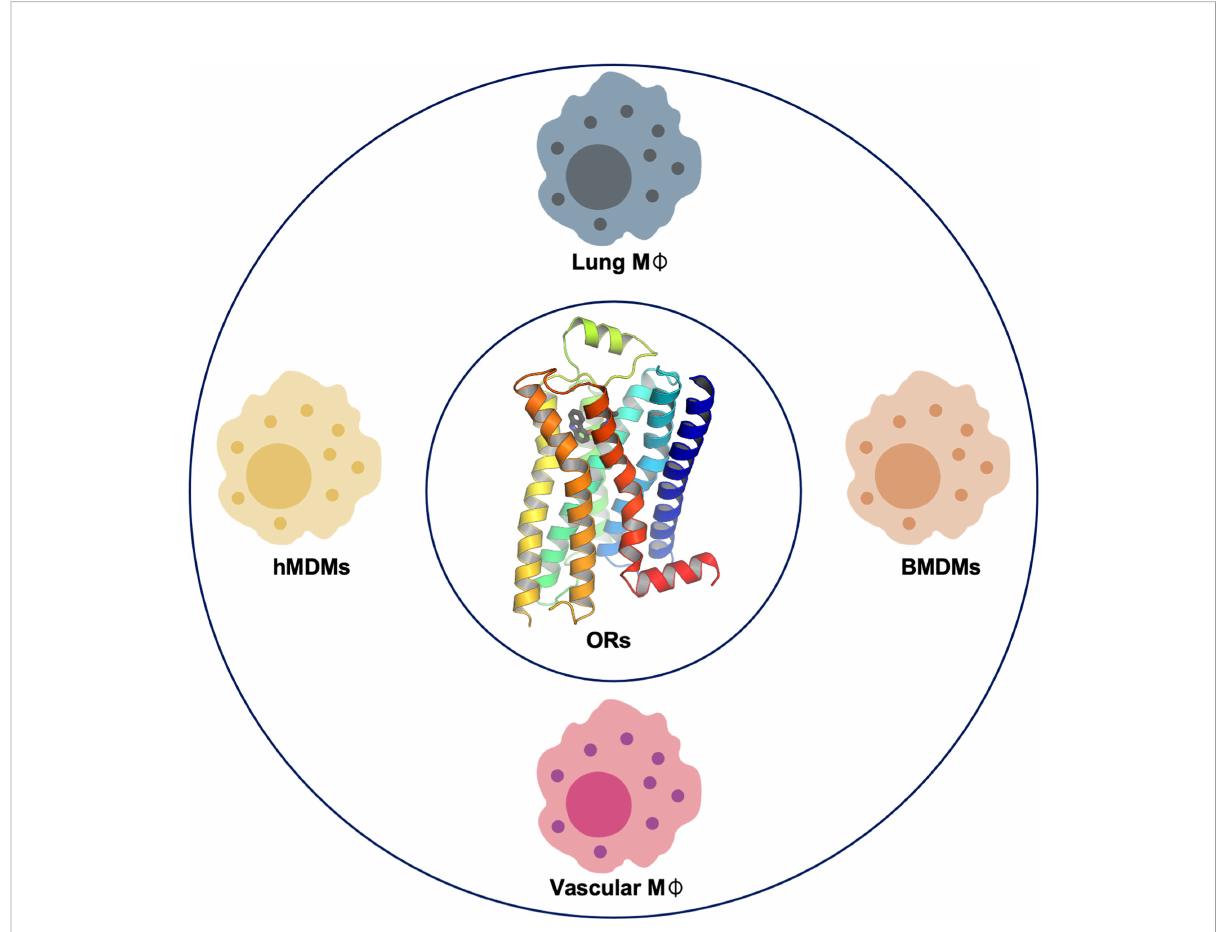
FIGURE 1 Olfactory receptor (OR) con fi rmed gene and protein expression in macrophages. Gene and protein expression of speci fi c ORs have been reported and con fi rmed in lung macrophages (15), bone marrow – derived macrophages (BMDMs) (13, 14), and vascular macrophages in both human and mice and human monocyte – derived macrophages (hMDMs)